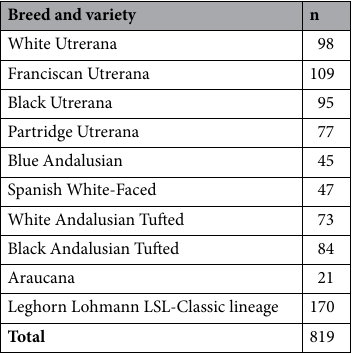
Table 5. Number of observations (n) sampled for egg quality measurement in each studied breed and variety.